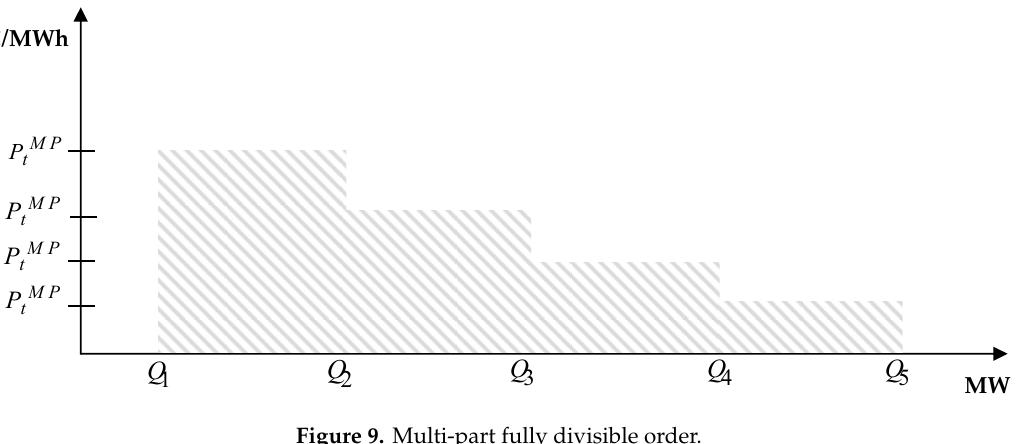
Figure 9. Multi-part fully divisible order.